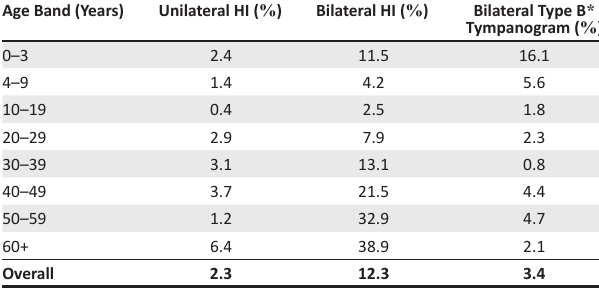
TABLE 3: Laterality of hearing loss & Tympanometry. Age Band (Years)